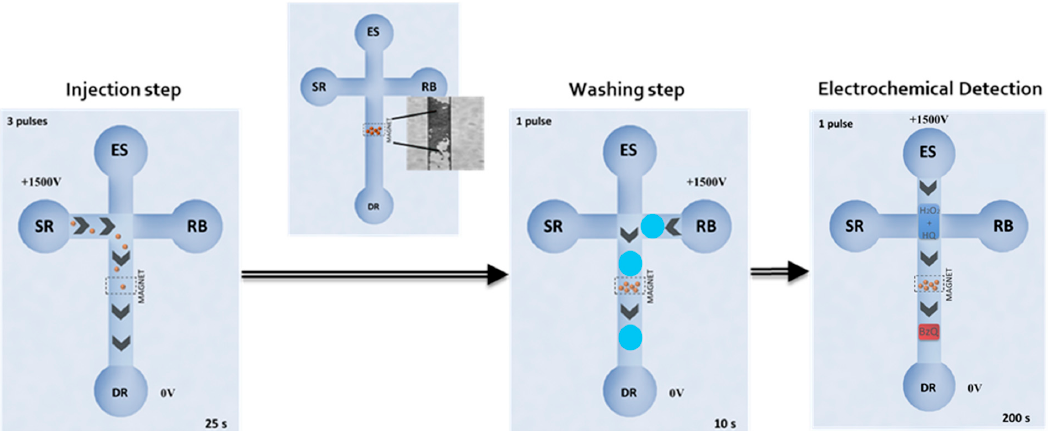
Figure 2. Electrokinetic protocol and electrochemical detection on EMC-Au. Sample reservoir (SR), running buffer (RB), enzymatic substrate reservoir (ER) and detection reservoirs (DR).